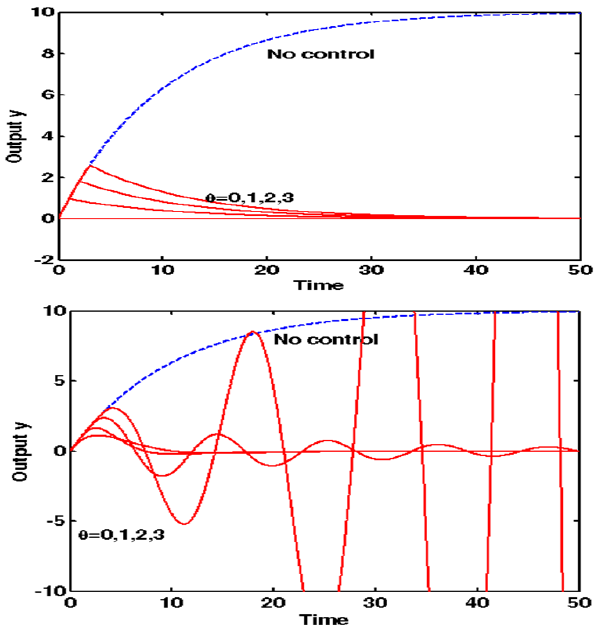
Figure 4: The problem with feedback... son of feedforward and feedback control with respect to time delay error. Nominal delay θ = 0 . Top: Feedforward control. Bottom: Feedback